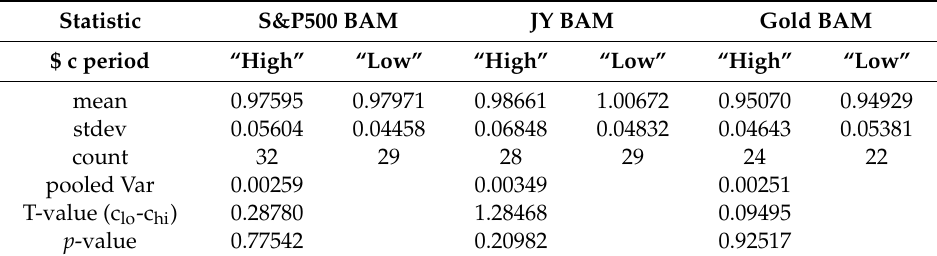
Table 8. The ($) BAM and its Di ff erence Across high and low ($) c